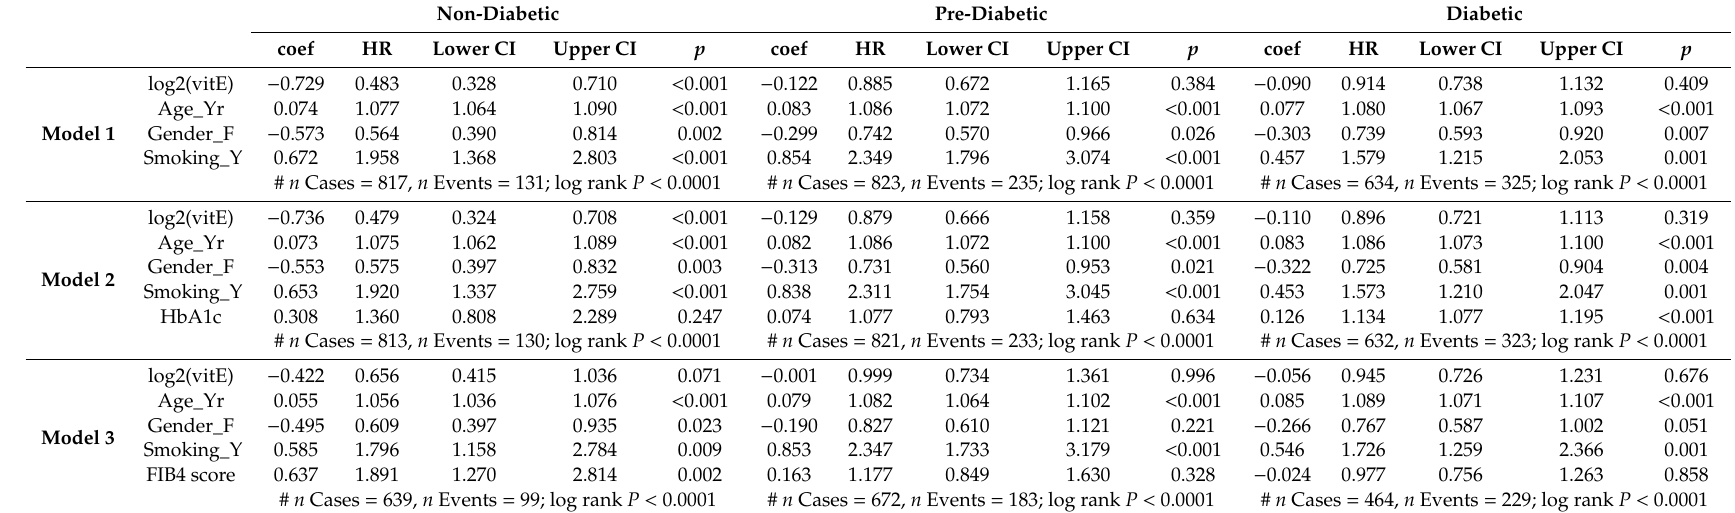
The e ff ects of various combinations of potential confounding factors were adjusted with multivariate models as follows: Model 1: survival (month) ~ log2 (vitamin E) + Age (Year) + Gender female + Smoking; Model 2: survival (month) ~ log2 (vitamin E) + Age (Year) + Gender female + Smoking + HbA1c; Model 3: survival (month) ~ log2 (vitamin E) + Age (Year) + Gender female + Smoking + FIB4 scores. Abbreviations: # n Cases: number of cases; n Events: number of all-cause death events; coef: beta coe ffi cient; CI: 95% confidence interval; HR: Hazard Ratio; log2(vitE): log2(vitamin E levels); Gender_F: female gender; Age_Yr: Age in years; Smoking_Y: current smoking